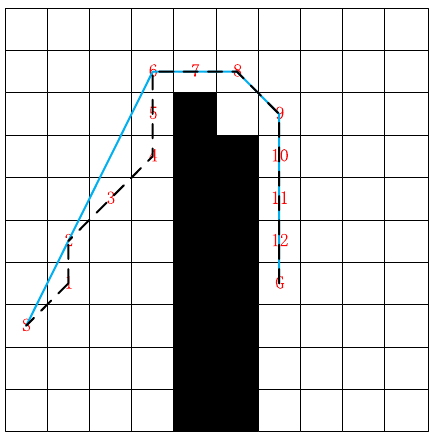
Figure 2. Schematic diagram of path smoothing